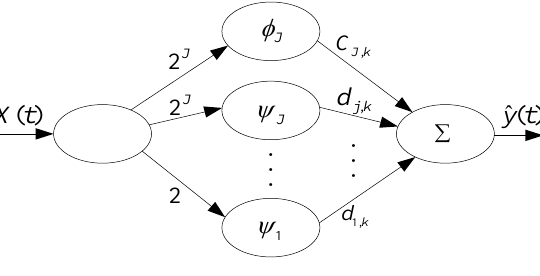
Figure 2. Prediction model structure of